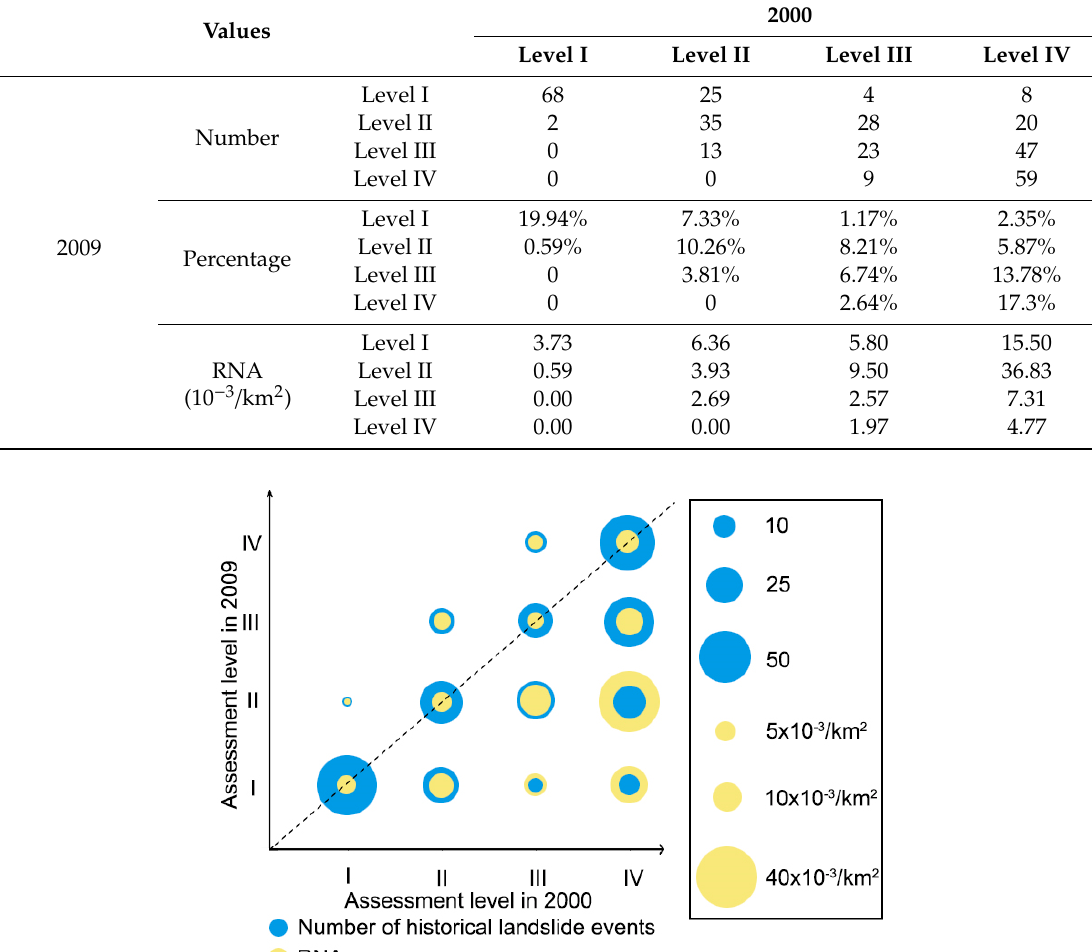
Figure 11. Changes in the assessment levels of historical landslide events from 2000 to 2009.